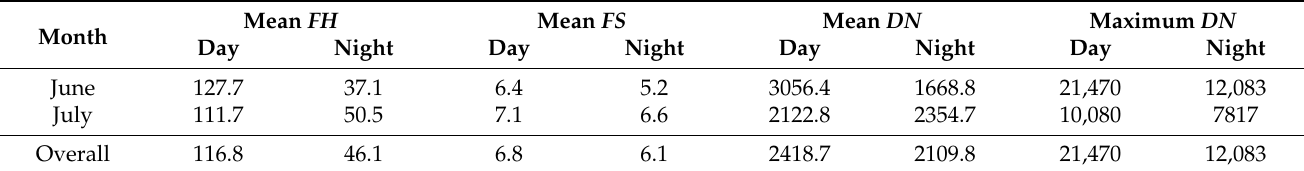
Table 3. Flight attributes by month using data from all individuals pooled.